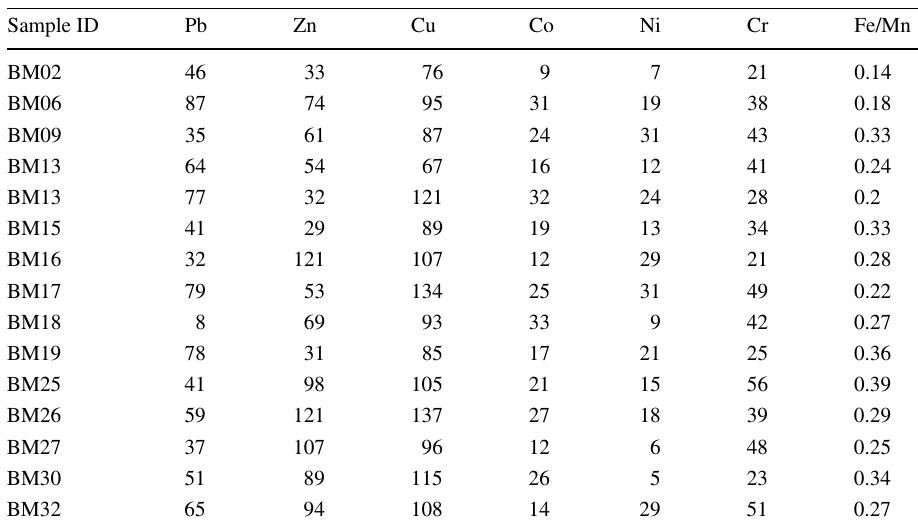
elements composition of Mn deposits of Lasbela area, Balochistan